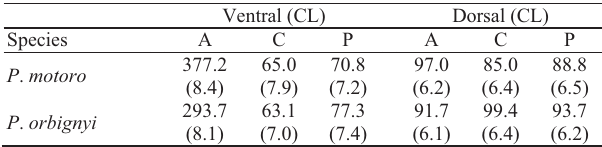
Table 5. Comparisons of the densities of neuromasts among the different body sections (A = anterior, C = central, and P = posterior) on both the dorsal and ventral surfaces of Potamotrygon motoro and P . orbignyi . Significant results marked with an asterisk (* = higher in A; ** = higher in P).